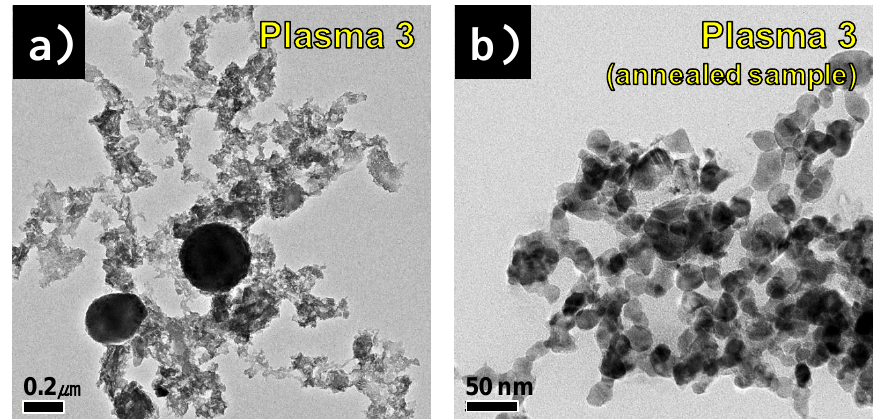
Figure 9. Cont. Figure 9. Cont.